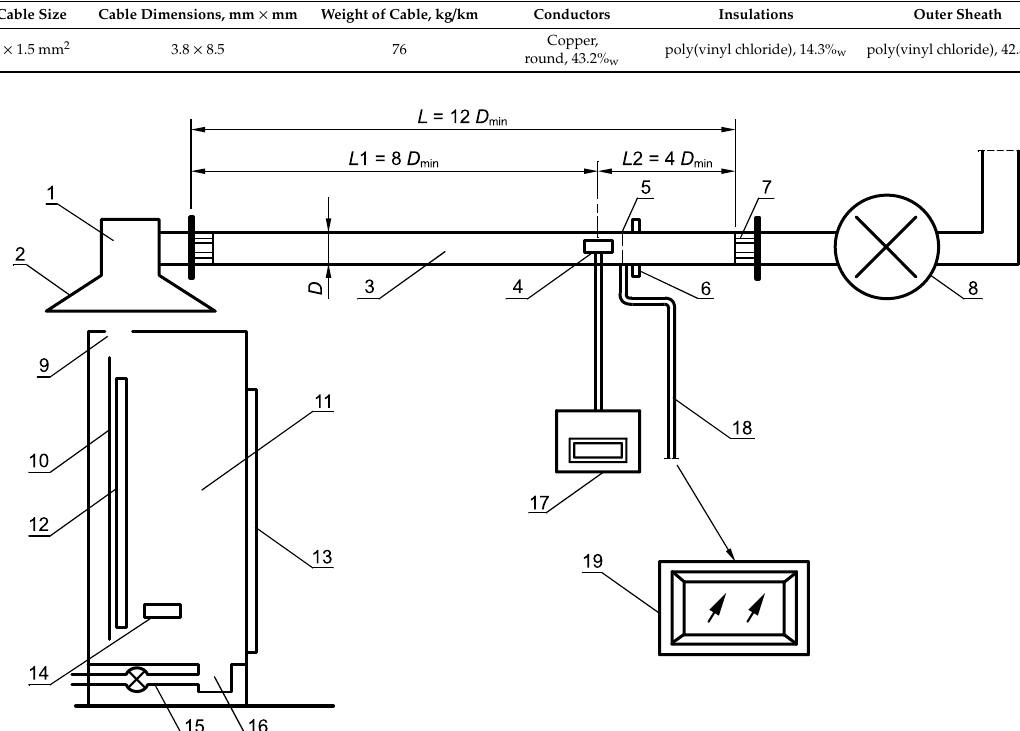
Figure 7. PVC-insulated and sheathed copper cable, which was the main component of all electrical installation specimens. Table 2. Characteristics of tested coaxial power cable.